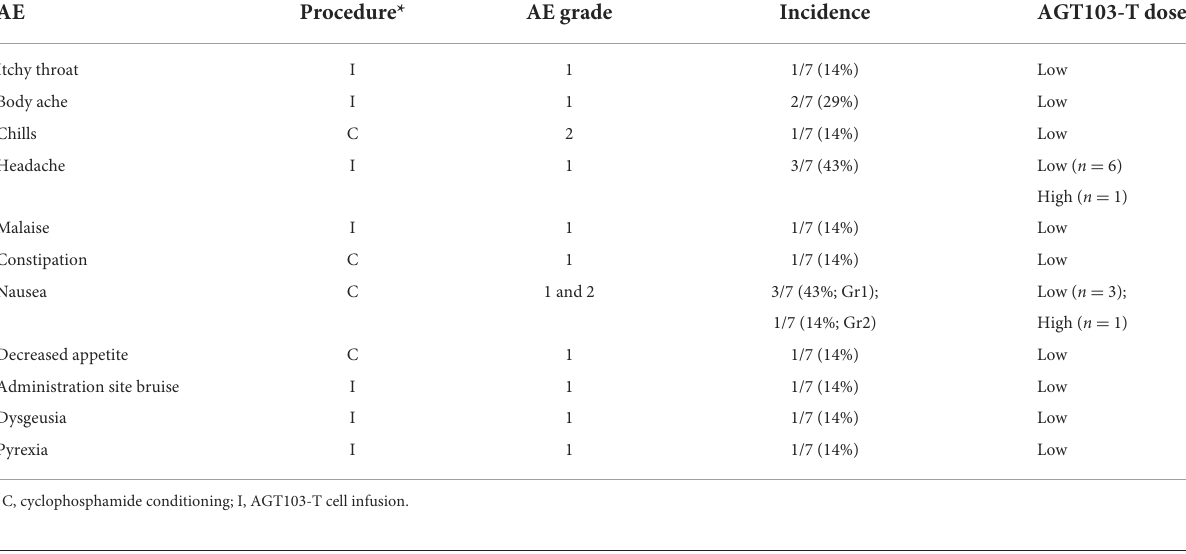
T cell product infusion. Initially, we assessed standard hematology markers including the white blood cell count, total lymphocyte count, absolute CD4 + T cell count and fraction of CD4 + T cells among total lymphocytes (Figure